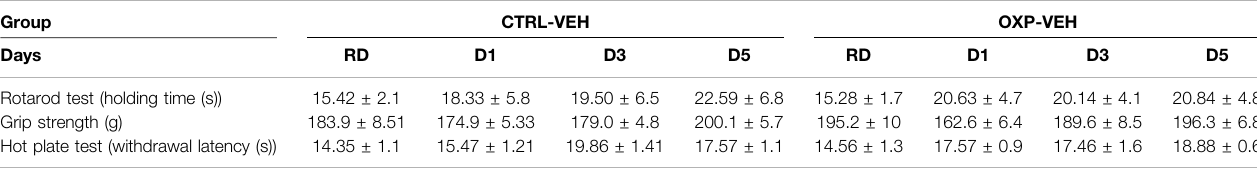
TABLE 1 | Effects of OXP on motor performance and the heat nociceptive response. Group CTRL-VEH OXP-VEH Days RD D1 Rotarod test (holding time